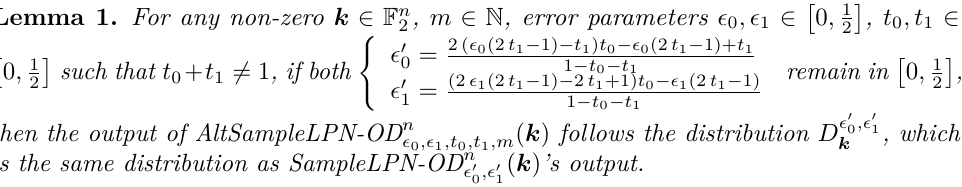
( k (cid:15) 0 ,(cid:15) 1 ,t 0 ,t 1 ,m